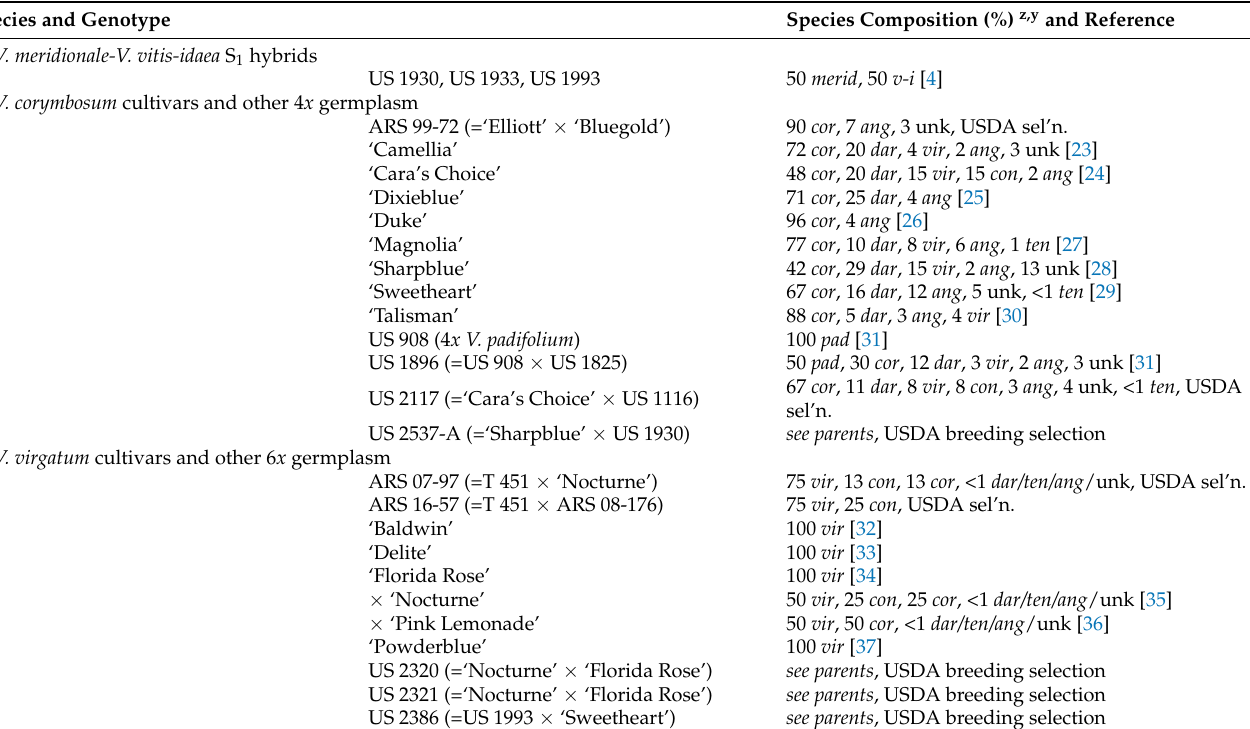
Table 4. Plant genotypes utilized in hybridization